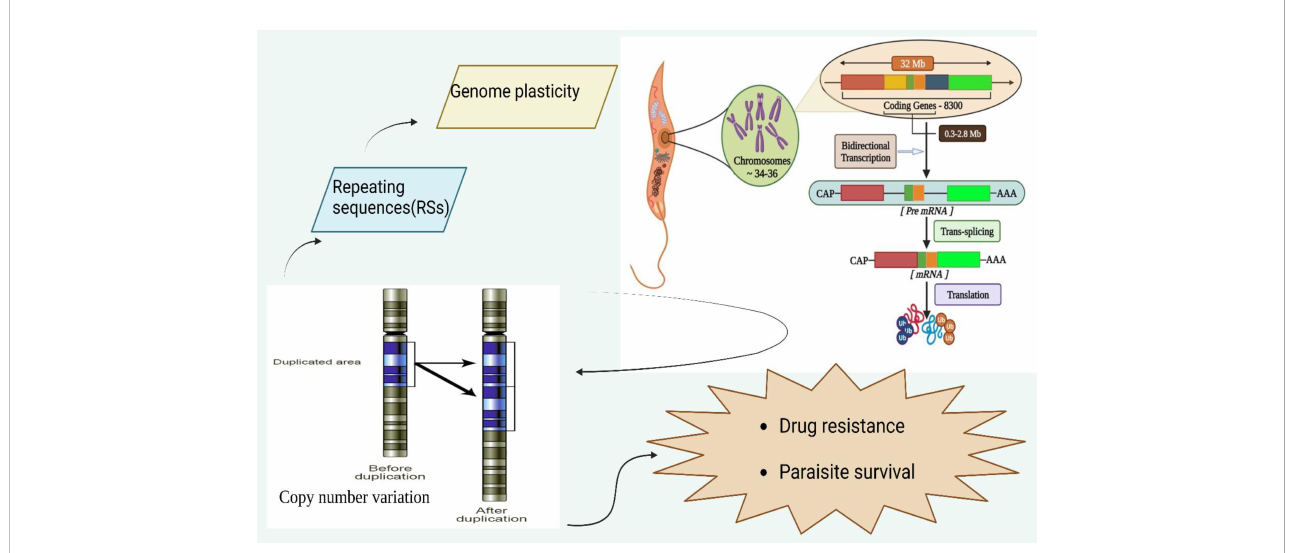
FIGURE 1 Genomic organization of leishmanial parasites and its regulation of Copy number variation to modulate and in fl uence drug resistance and parasite survival. The leishmanial species contains 34-36 chromosomes where a vast polycistronic unit spans through the protein-coding genes with a size from 0.3 to 2.8 mb. The transcription of these lengthy polycistronic units occurs bi-directionally from the start sites situated at switch regions of the